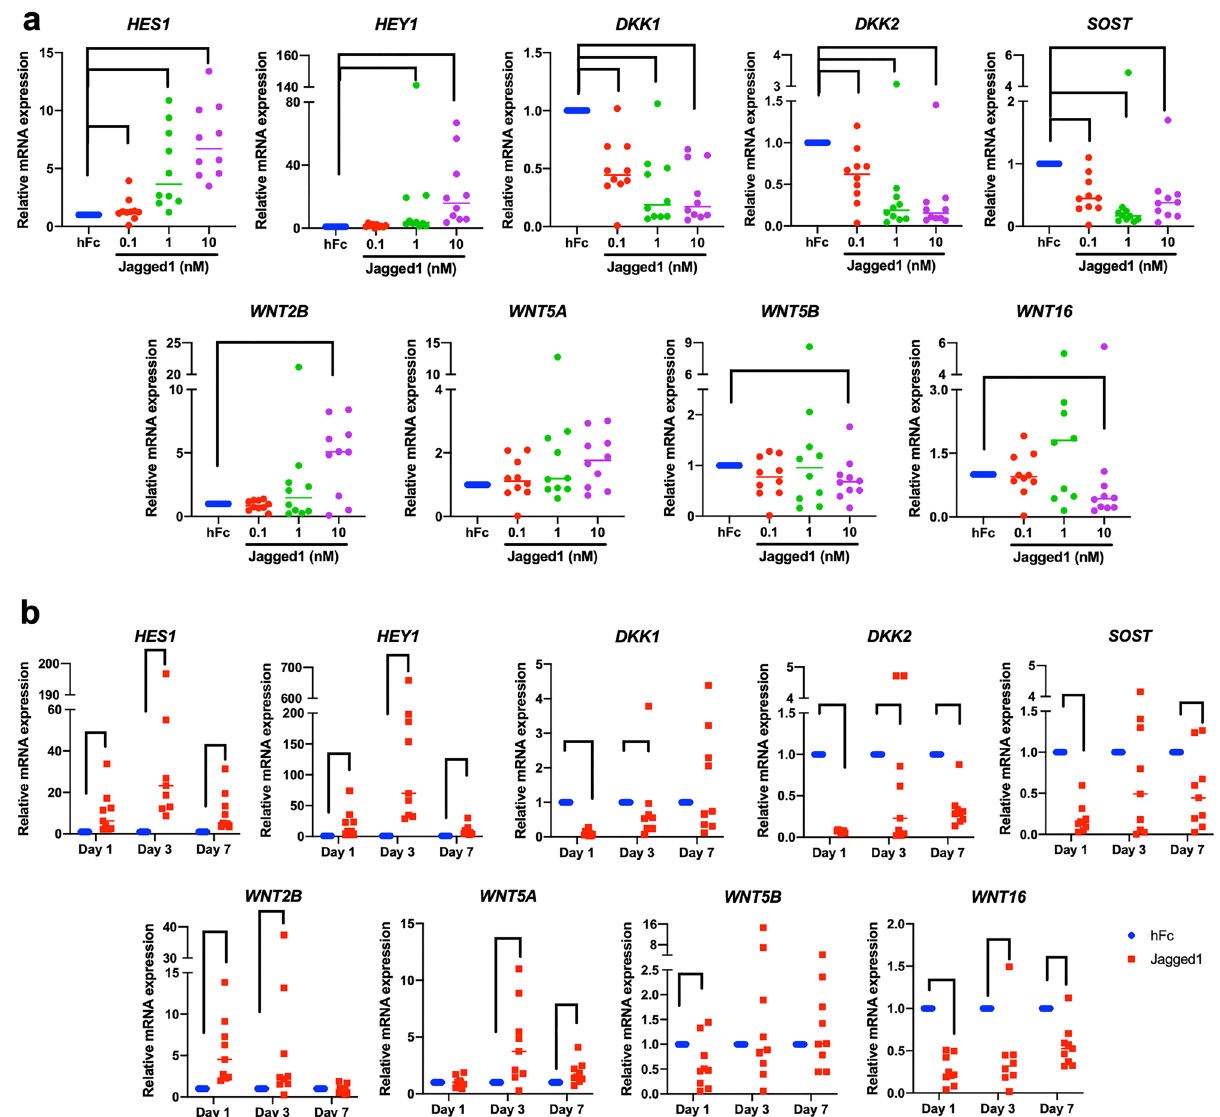
Figure 3. Dose and time course experiment of Jagged1 promotes Wnt related gene expression in hDPSCs. Correlation of Notch and Wnt pathways. ( a ) The mRNA levels of Notch-related genes ( HES1 and HEY1 ) and Wnt-related genes (WNT2B, WNT5A, WNT5B, WNT16, DKK1, DKK2, and SOST) were measured using real-time polymerase chain reaction after exposed to different Jagged1 concentrations for 24 h. ( b ) The mRNA expression of hDPSCs treated with 10 nM Jagged1 was evaluated at day 1, 3, and 7. Bars indicate a significant difference between groups ( p <